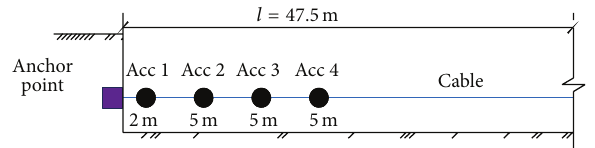
Figure 2: Layout of full-scale cable